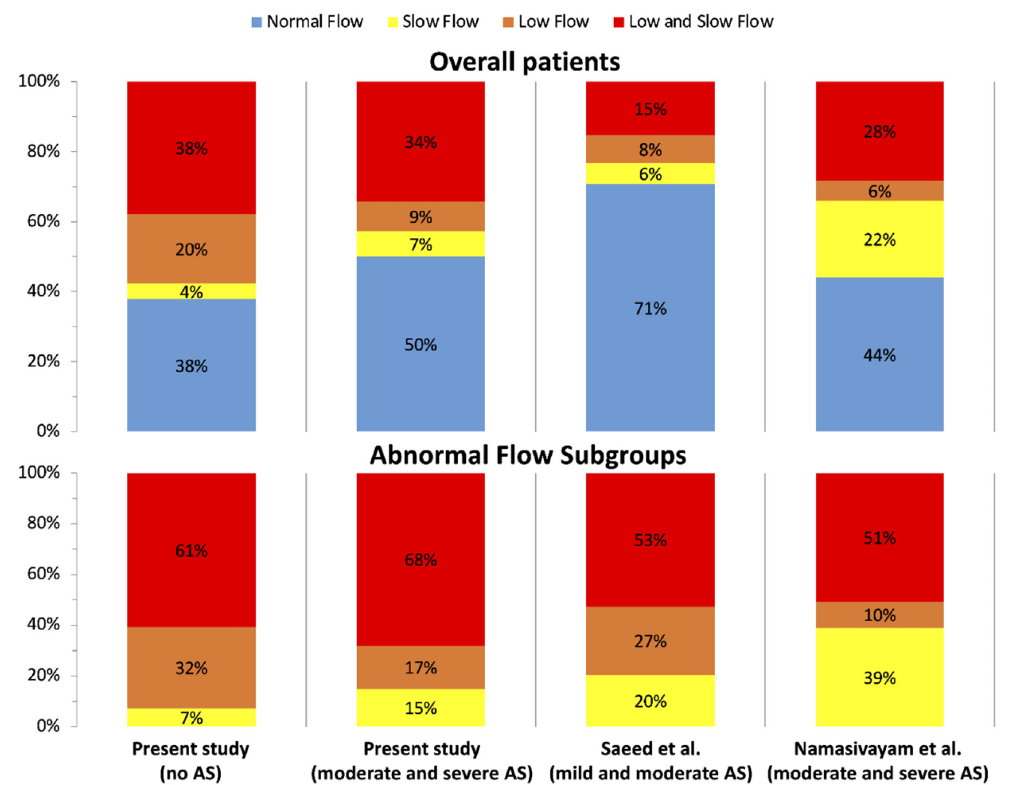
Figure 7. Distribution of flow in our cohort and previous studies from Saeed et al. [19] and Namasivayam et al. [12] on various AS grade patients.